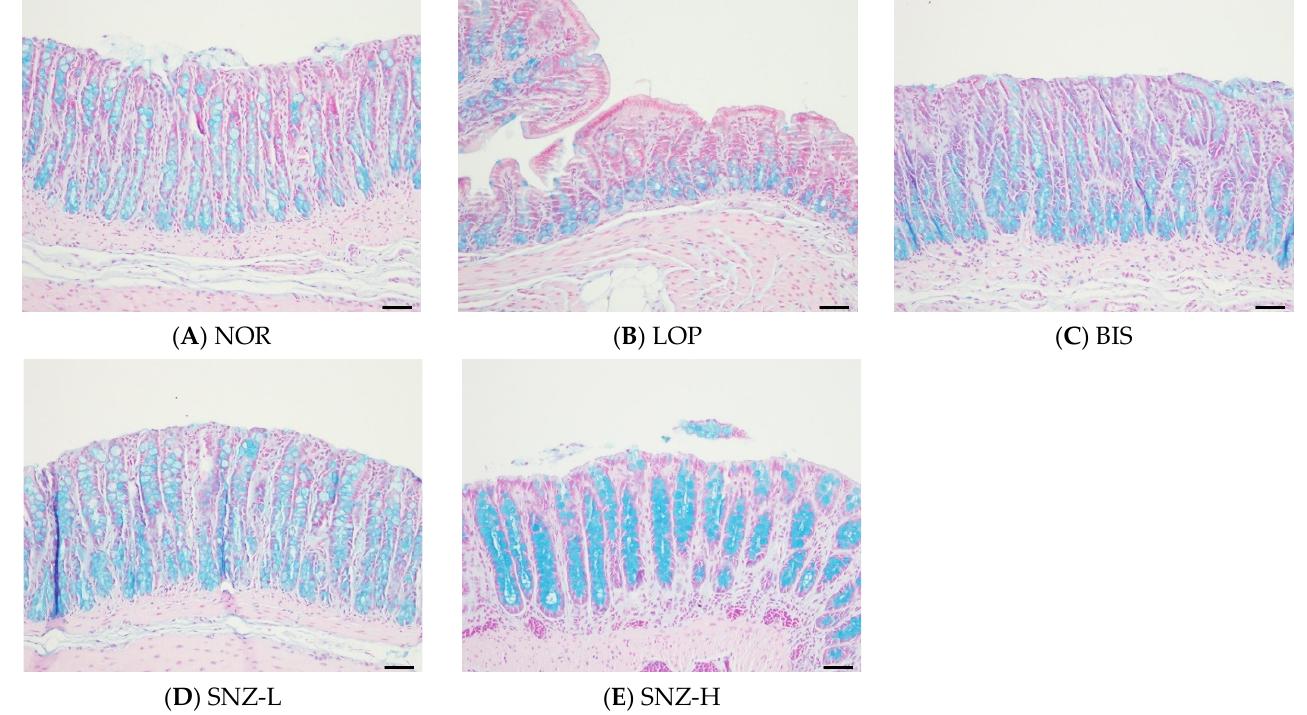
Figure 4. Effects of B. coagulans SNZ 1969 on mucous secretion capacity in loperamide-induced constipation rats. ( A ) NOR: Normal group, ( B ) LOP: Loperamide treated group, ( C ) BIS: Loperamide and Bisacodyl 8 mg/kg treated group, ( D ) SNZ-L: Loperamide and B. coagulans SNZ 1969 at 1 × 10 8 CFU/day treated group, ( E ) SNZ-H: Loperamide and B. coagulans SNZ 1969 at 1 × 10 10 CFU/day treated group. Magnification 200×. Scale bar = 50 μ m.